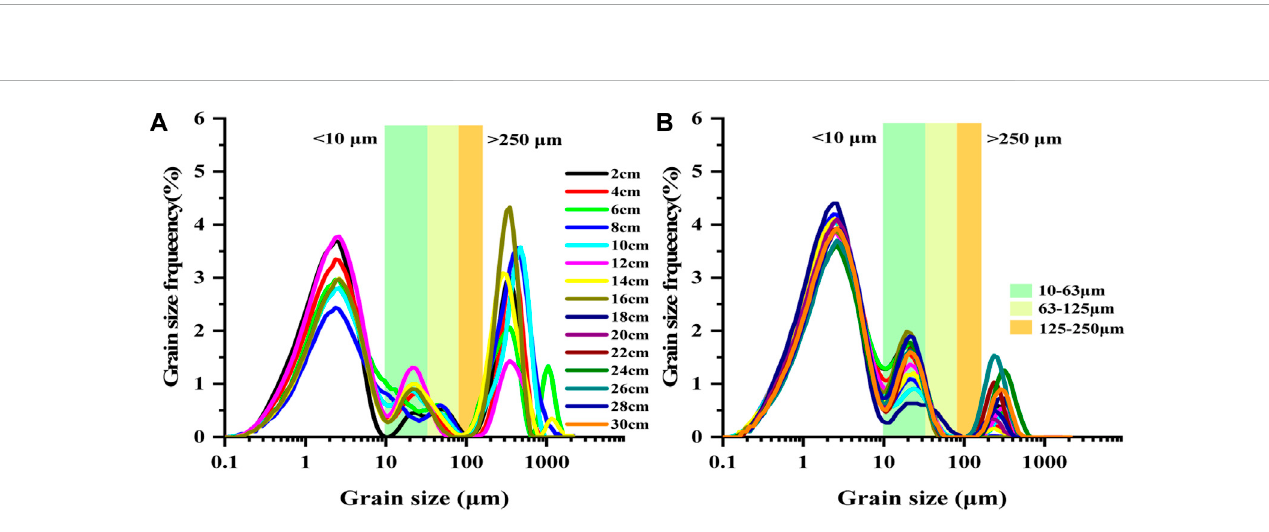
FIGURE 5 Grain size frequency of aeolian sediment on two